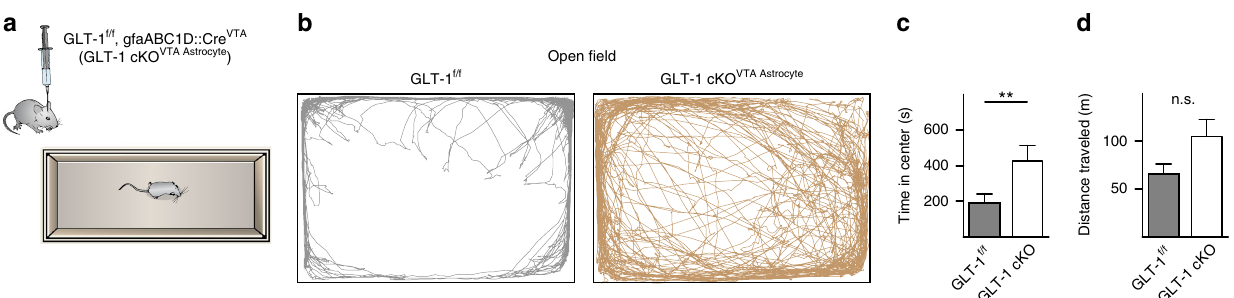
Fig. 8 GLT-1 removal from VTA astrocytes disrupts endogenous avoidance behavior. a Schematic depicting experimental design. b Track plots from a GLT- 1 f/f mouse with only a fl uorescent reporter (eYFP) on astrocytes displaying normal thigmotaxis in an open fi eld (left), and a GLT-1 cKO VTAAstrocyte (GLT-1 f/f , gfaABC1D::Cre VTA ) mouse with increased tendency to explore the center of the open fi eld (right). c , d GLT-1 cKO VTA Astrocyte mice spent more time exploring the center of the open fi eld without affecting locomotor activity ( d ; unpaired t -test t (16) = 1.981, P = 0.065, n = 9 mice). ** p < 0.01; Error bars indicate ± SEM